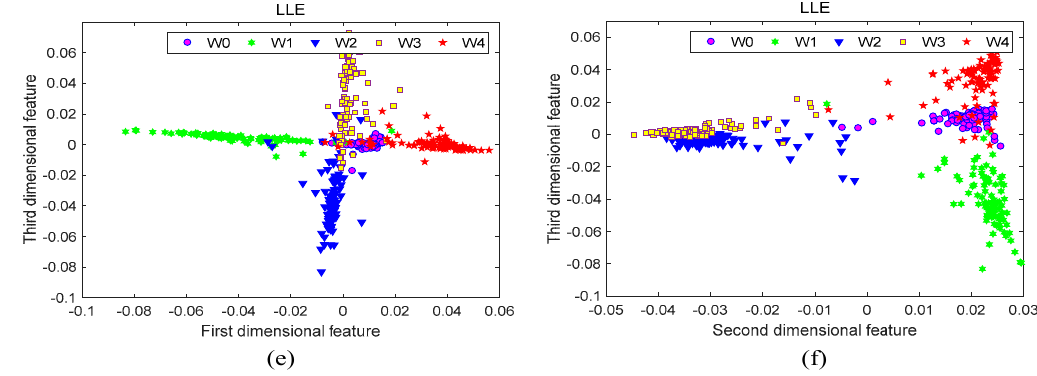
Figure 8. Dimensional reduction effects of other dimensions for Principal Component Analysis (PCA), Kernel Principal Component Analysis (KPCA), and Locally Linear Embedding (LLE): ( a ) The first and the third dimensional features of PCA; ( b ) The second and the third dimensional features of PCA; ( c ) The first and the third dimensional features of KPCA; ( d ) The second and the third dimensional features of KPCA; ( e ) The first and the third dimensional features of LLE; ( f ) The second and the third dimensional features of LLE.